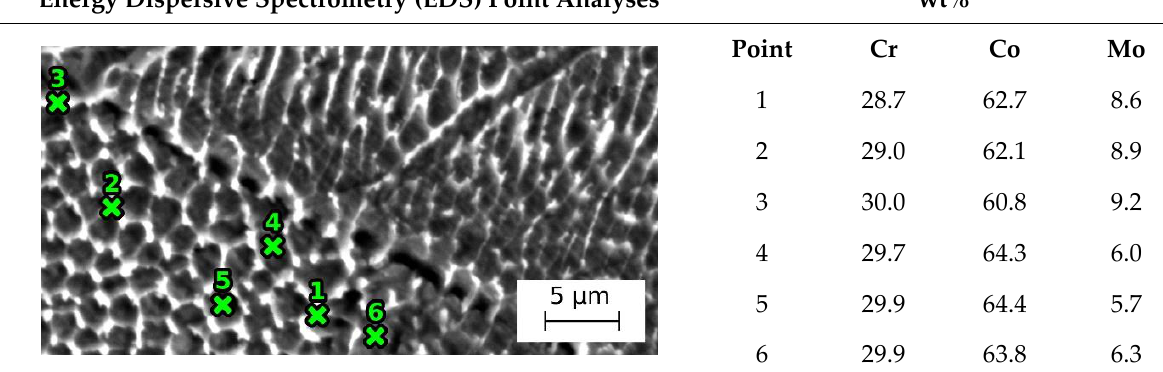
Figure 2. Chemical composition inside cells and in the intercellular network.